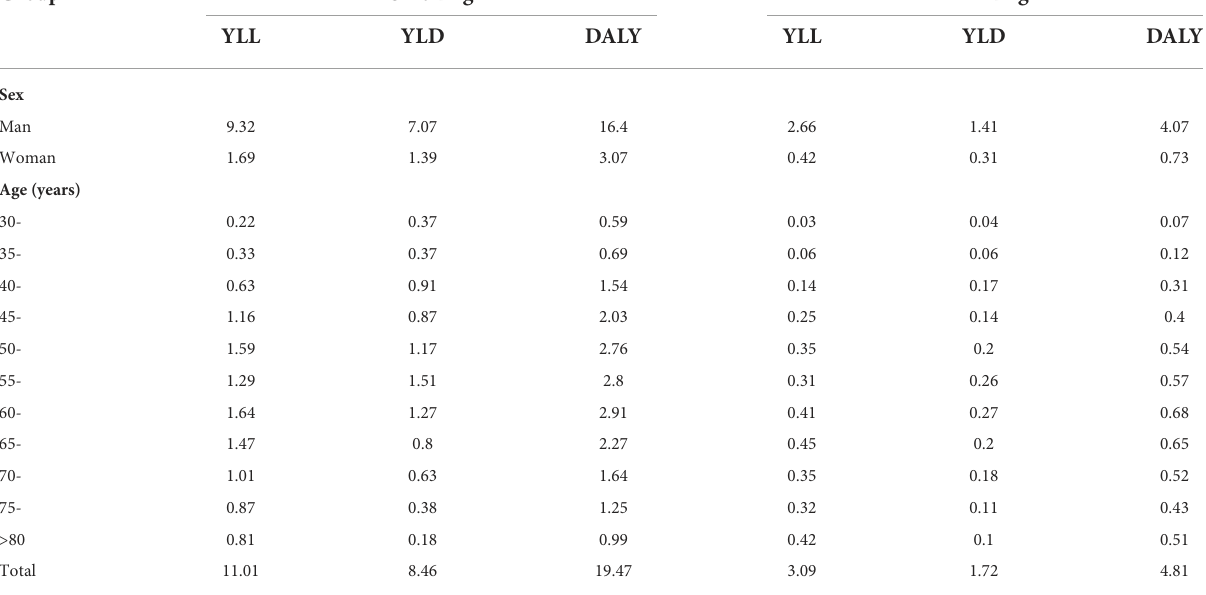
TABLE 5 Burden of major chronic diseases attributed to smoking and drinking in different sex and age groups in the Shanxi Province (10,000 person-years). Group Smoking Drinking YLL YLD DALY YLL YLD